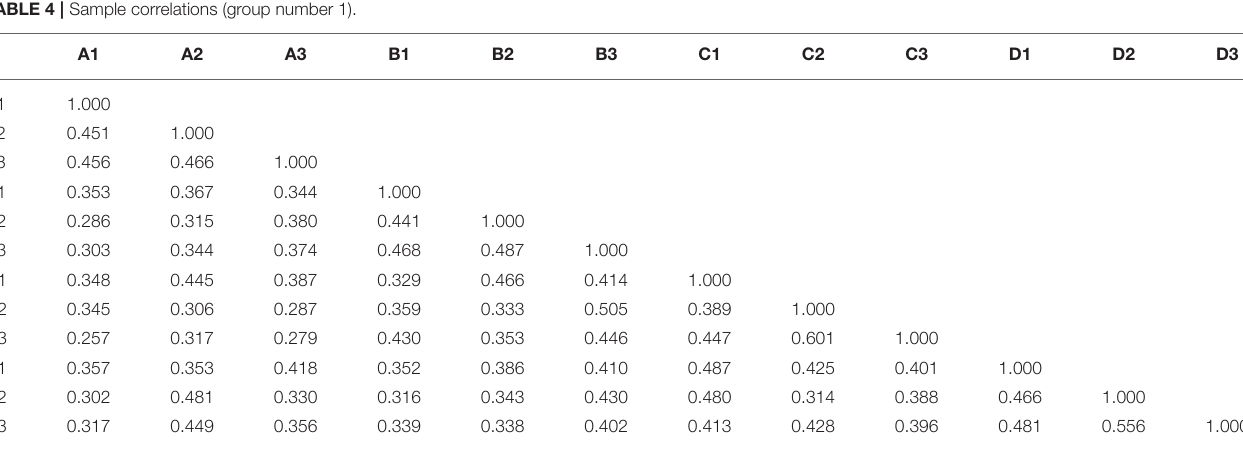
TABLE 4 | Sample correlations (group number